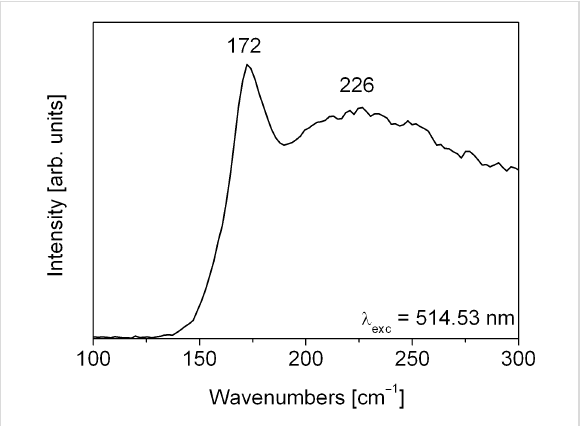
Figure 5: Raman spectrum of CuInSe 2 nanorod arrays.